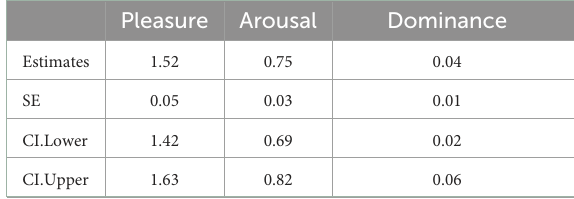
TABLE 4 Mediating effect of emotional